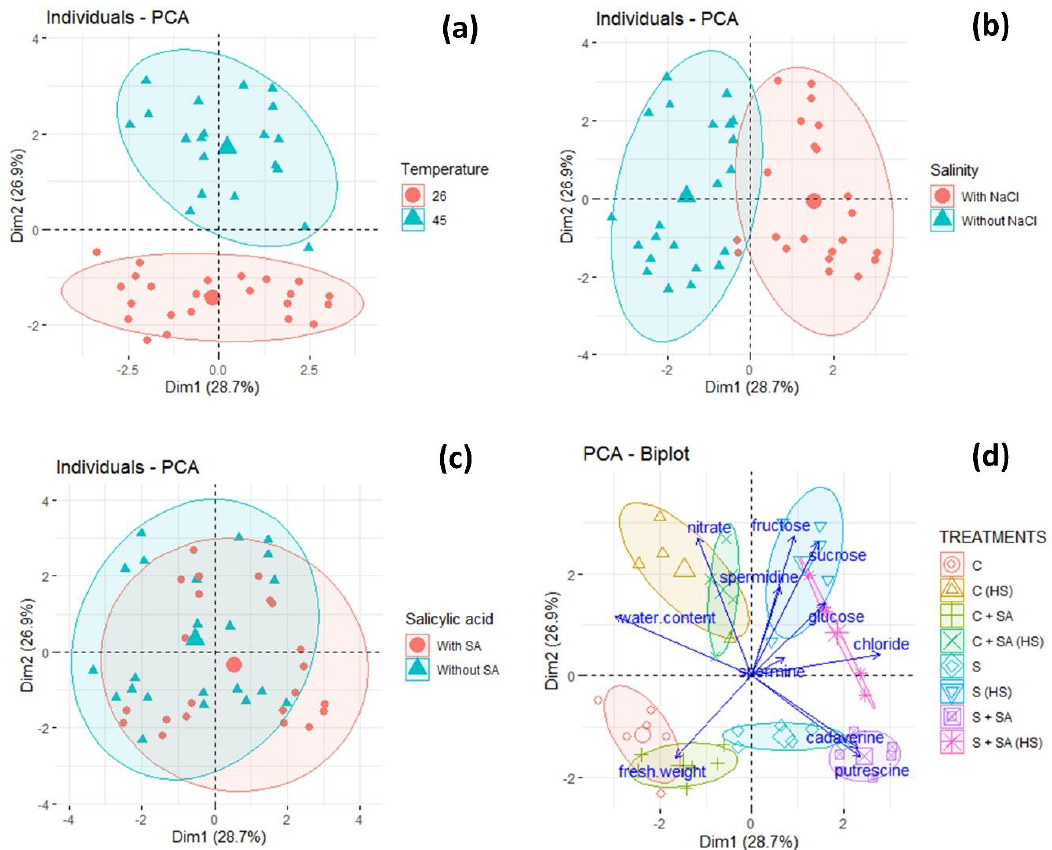
Figure 5. Principal component analysis (PCA) of the parameters analyzed in pepper plants cultivated with or without heat-shock and/or salinity, and with or without salicylic acid. ( a ) Cases are grouped by the temperature conditions applied; ( b ) cases are grouped by the salinity conditions applied; ( c ) cases are grouped by the salicylic acid conditions applied; and ( d ) PCA biplot where the cases are grouped by the treatments applied: C, control; S, salinity; SA, salicylic acid; HS, heat stress.